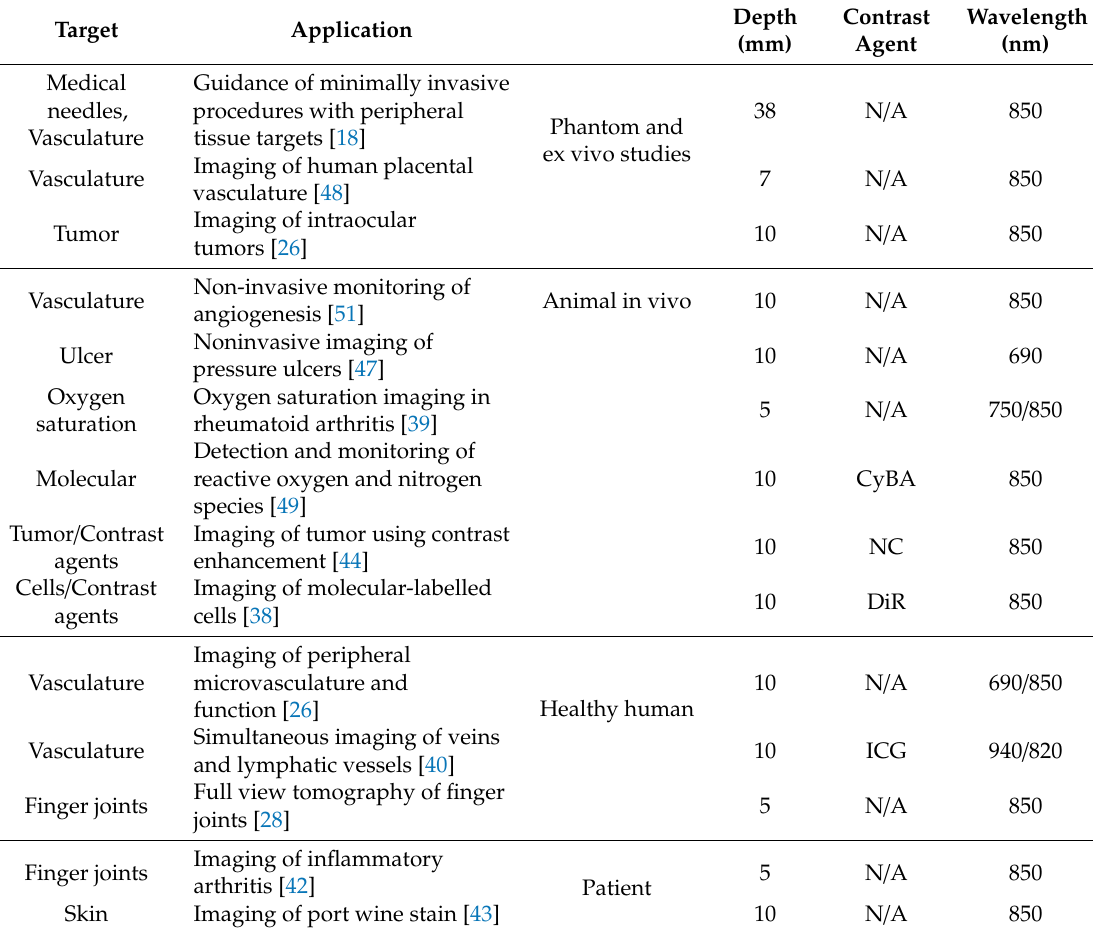
Table 3. Summary of the preclinical and clinical applications of LED-based PAI. Adapted with permission from Y. Zhu, T. Feng, Q. Cheng, X. Wang, S. Du, N. Sato, J. Yuan and M. Kuniyil Ajith